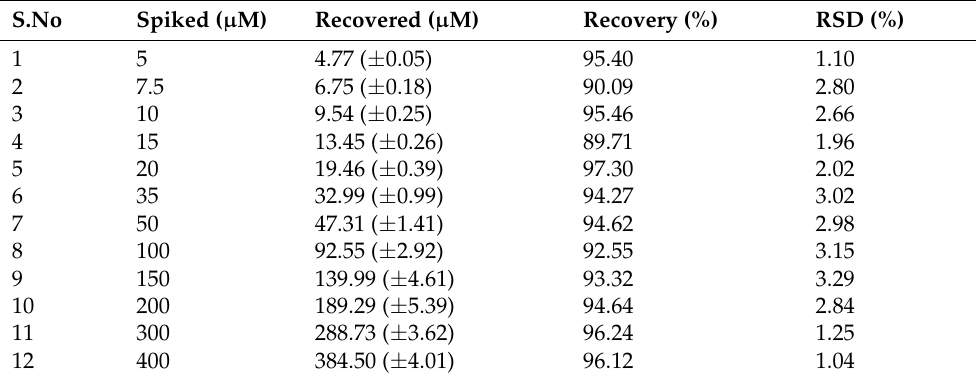
Table 2. Recovery table showing percent recoveries of creatinine in spiked serum samples and RSD values.